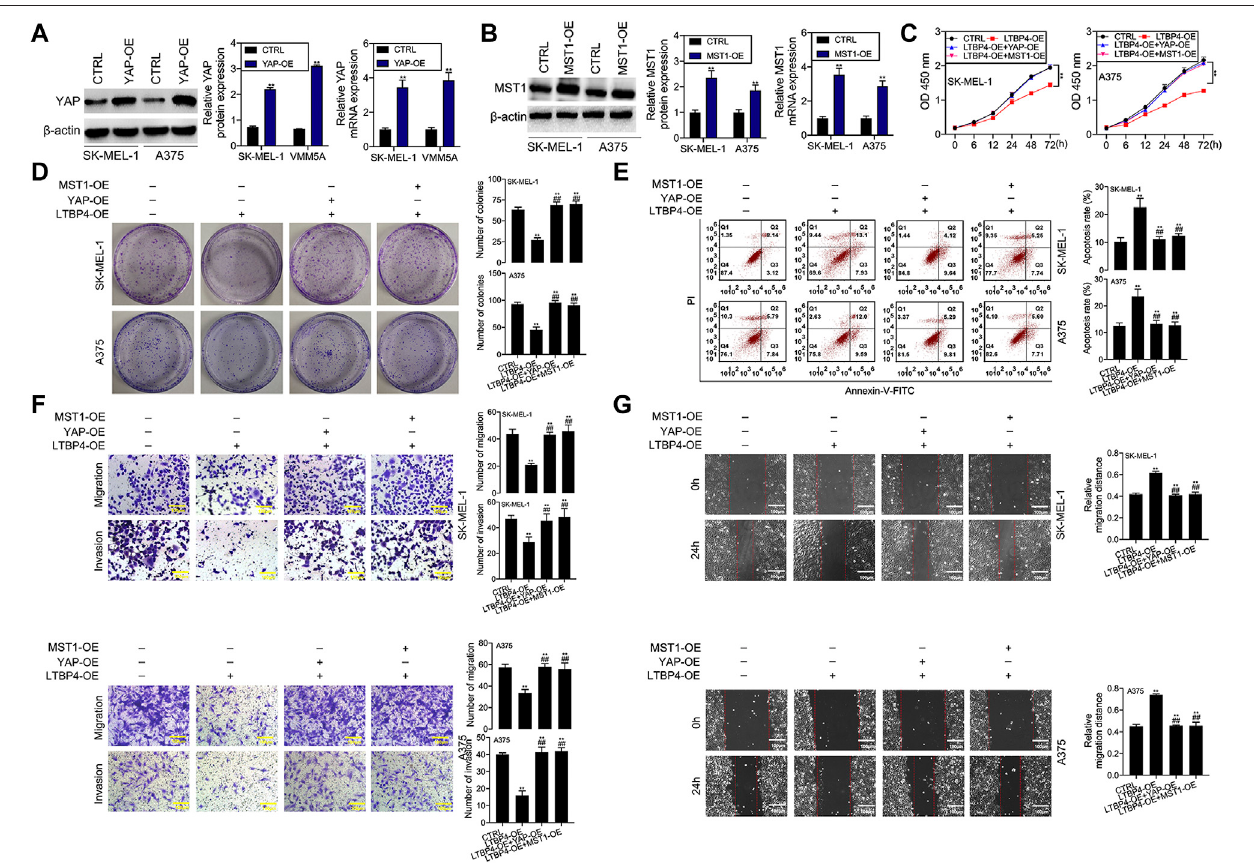
FIGURE 9 | Overexpression of LTBP4 inhibited the proliferation, invasion and migration, and promoted the apoptosis of melanoma cells via the Hippo-YAP1 signaling. (A) TheproteinandmRNAlevelsofYAP1inYAP1expressingplasmidstransfected SK-MEL-1andA375cellsweredetectedbywesternblottingandRT-PCR assays. (B) The protein and mRNA levels of MST1 in MST1 expressing plasmids transfected SK-MEL-1 and A375 cells were detected by western blotting and RT-PCR assays. After LTBP4 expressing plasmids and YAP1/or MST1 expressing plasmids were co-transfected into SK-MEL-1 and A375 cells, (C) the viability was detected byCCK-8 assay, (D) theproliferation was detected by colony formation assay, (E) the apoptosis level was detected by fl owcytometry assay, (F) the migration and invasion were detected by transwell assay, and (G) the migration was detected by wound healing assay. β -actin was used as a load control. Data are presented as the mean ± standard deviation. ** p < 0.01 vs CTRL group and ## p < 0.01 vs LTBP4-OE group.